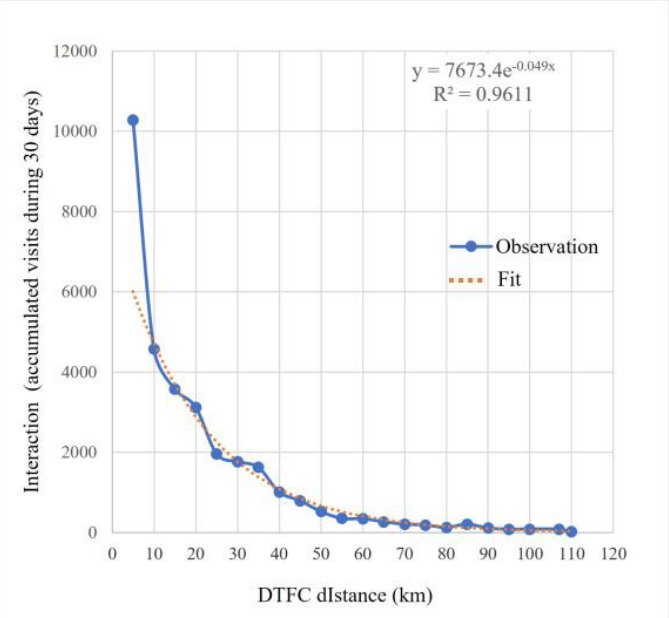
Figure 6. Interaction strength with the DTFC distance distribution of EV owners’ charging-trips. The blue curve represents the observation data, and the yellow curve show the fitted results. There was a significant turning point at 10km. Besides, it can be seen that a peak appears at the 20km and 35km point respectively.